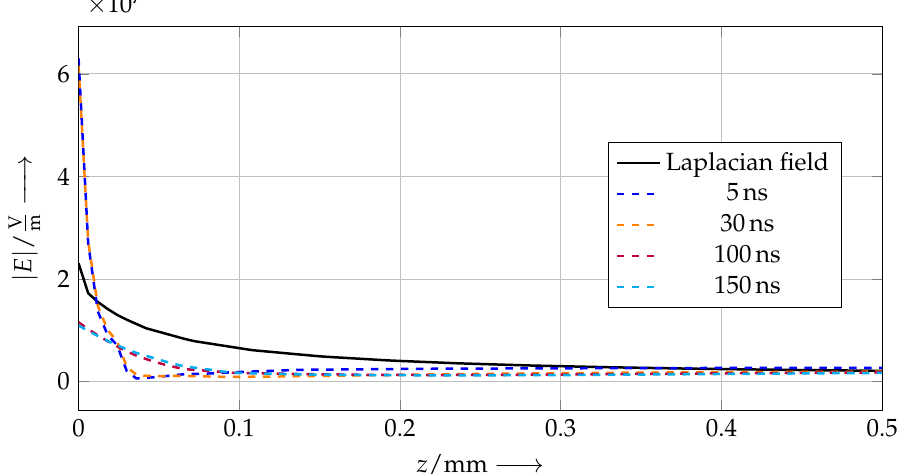
Figure 9. Electric field at the needle tip with and without consideration of space charge